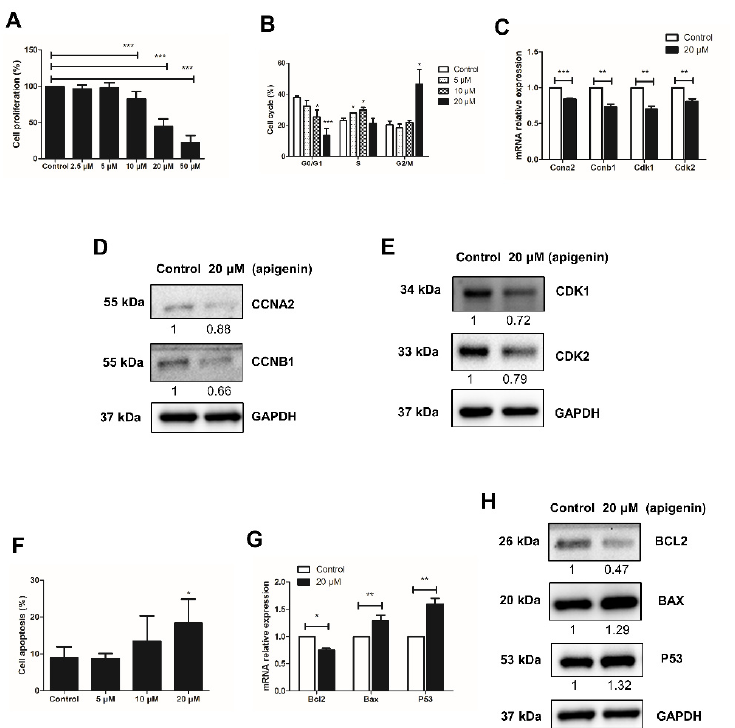
Figure 1. Effects of different concentrations of apigenin treatment on the proliferation and apoptosis of spermatogonia. ( A ) Cell proliferation was determined by CCK-8 assay after different concentrations of apigenin treatment for 48 h. ( B ) Cell cycle was analyzed by flow cytometry after applying different concentrations of apigenin treatment for 48 h. ( C ) Relative mRNA expression of Ccna2 , Ccnb1 , Cdk1 , and Cdk2 examined by RT-qPCR in spermatogonia treated with 0 and 20 µ M apigenin for 48 h. ( D , E ) The protein levels of CCNA2, CCNB1 ( D ), and CDK1 as well as CDK2 ( E ) were detected by Western blotting in spermatogonia treated with 0 and 20 µ M apigenin for 48 h. ( F ) Cell apoptosis was analyzed by flow cytometry after applying different concentrations of apigenin for 48 h. ( G ) Relative mRNA expression of Bcl2 , Bax , and P53 examined by RT-qPCR in spermatogonia treated with 0 and 20 µ M apigenin for 48 h. ( H )The protein levels of BCL2, BAX, P53 were detected by Western blotting in spermatogonia treated with 0 and 20 µ M apigenin for 48 h. Data from three independent experiments are expressed as mean ± SEM. * indicates statistical significance. * p < 0.05, ** p < 0.01, and *** p <